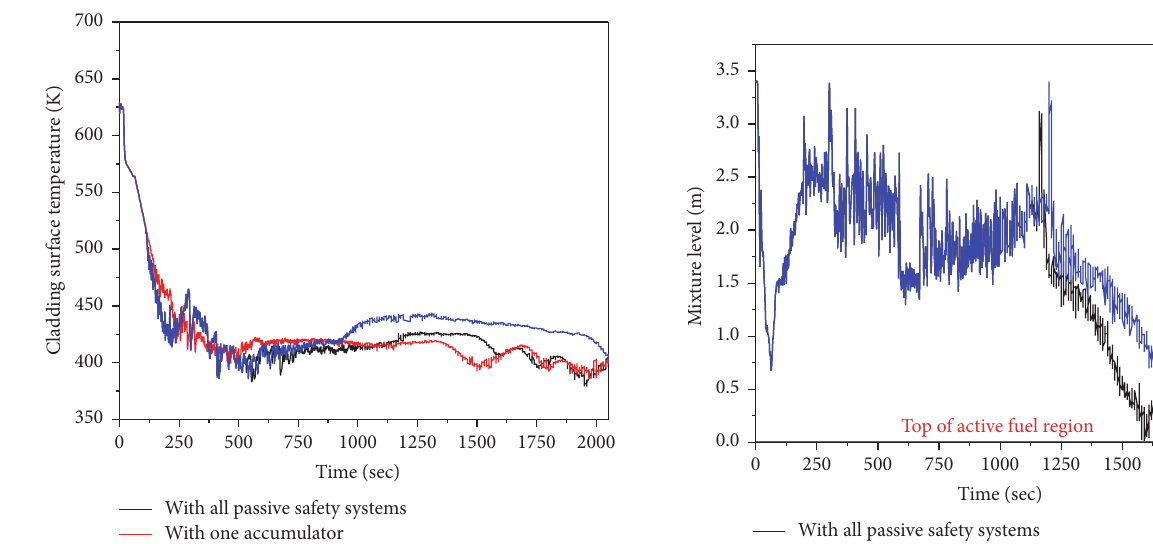
Figure 16: Comparison of primary system depressurization during LOCA in case-1 and case-4.